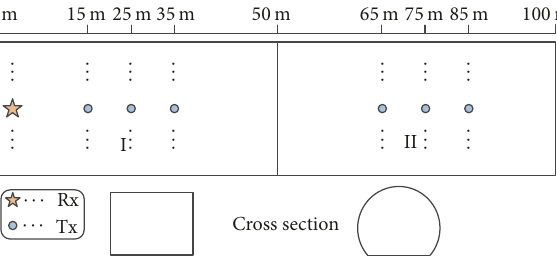
Figure 6: Measurement location illustration for virtual MIMO measurements.